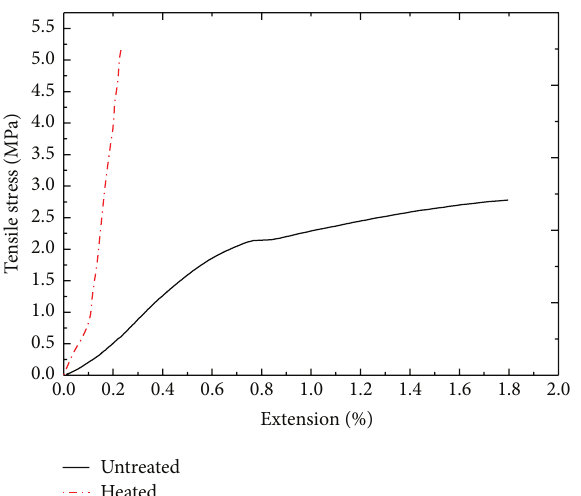
Figure 7: Tensile stress-strain curve of the untreated CA fibre web and the heat-treated CA webs. Cross-head speed was 10mmmin −1 , web thickness: 150 𝜇 m, sample width: 6.35